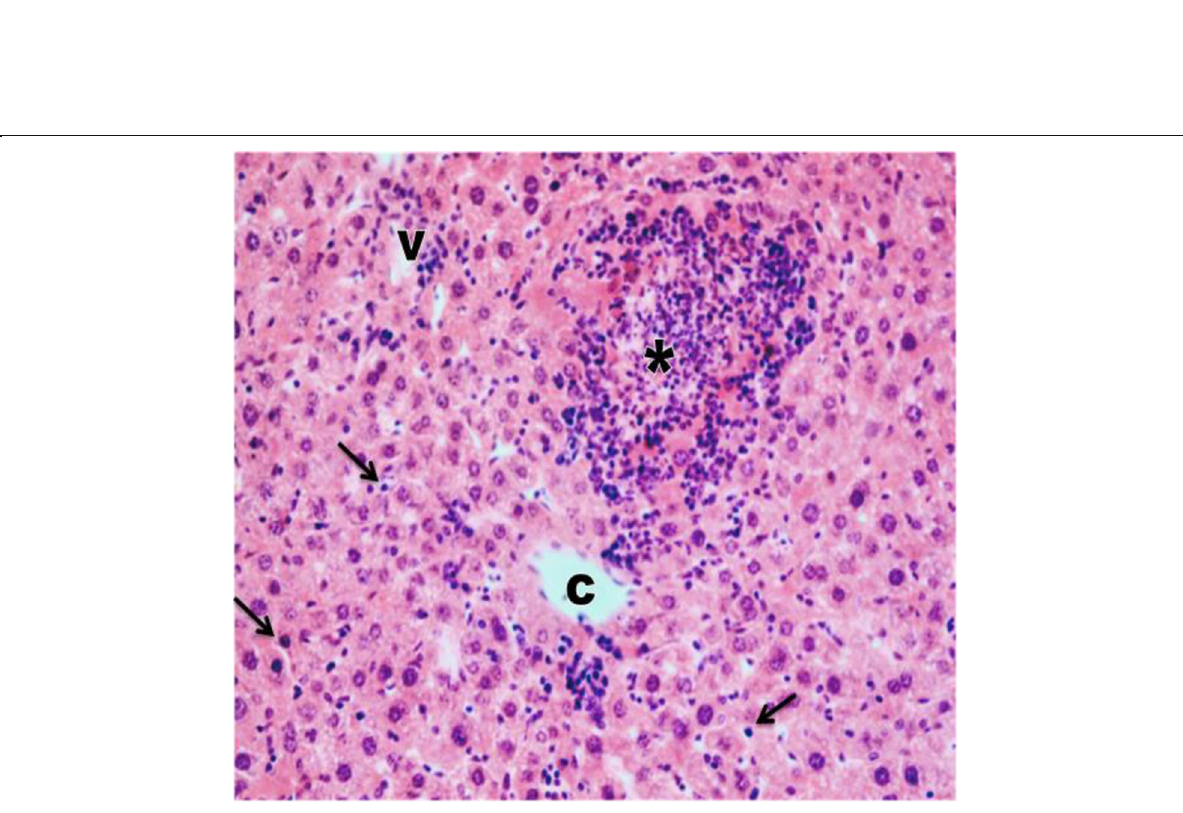
Fig. 7 Photomicrograph of a section of the liver of treated mouse with Adamine (20 mg/kg b.wt.) for 10 days showing hepatocytes with cytoplasmic vacuolation (V), pyknotic nuclei (arrows), and focal area of necrosis is also appear (*). (H&E, × 400)